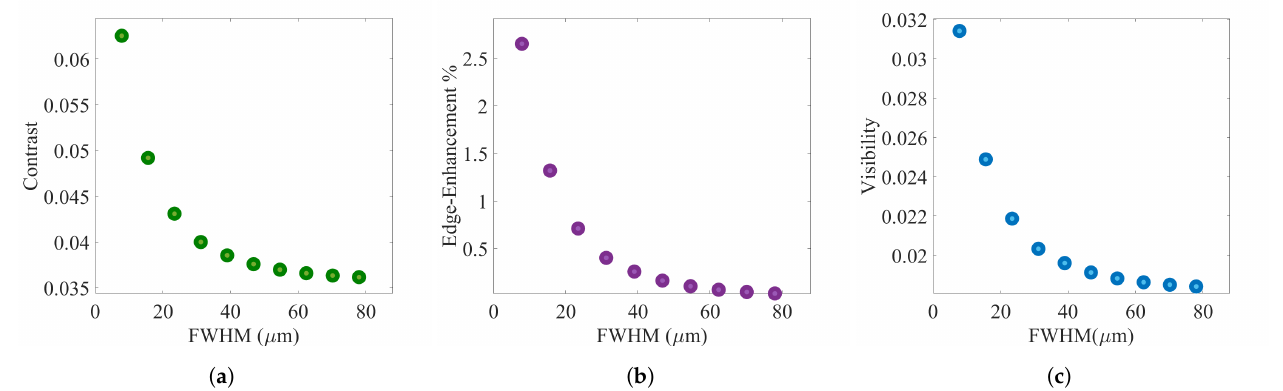
Figure 7. ( a – c ) Simulation results of contrast, edge-enhancement, and visibility for a PB-XPCi system carried out for a PEEK wire with 585 µ m in diameter as a function of different detector modulation transfer function values ( MTF d ).